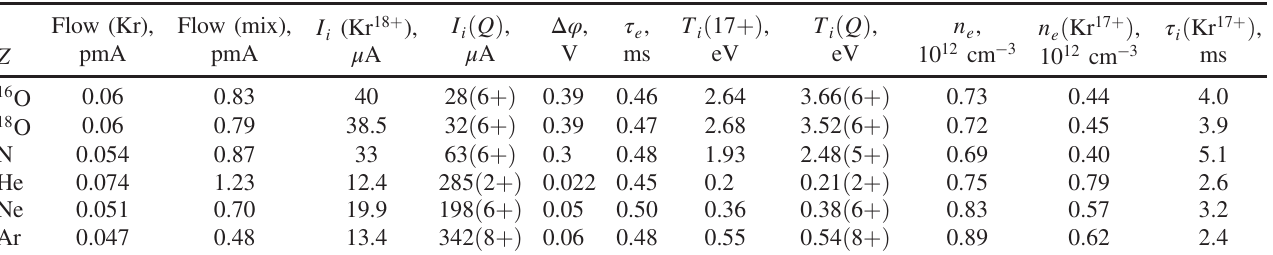
TABLE III. Main parameters of the krypton plasmas mixed with different gases. Krypton content is Kr ¼ 15 %, T ¼ 500 P rf